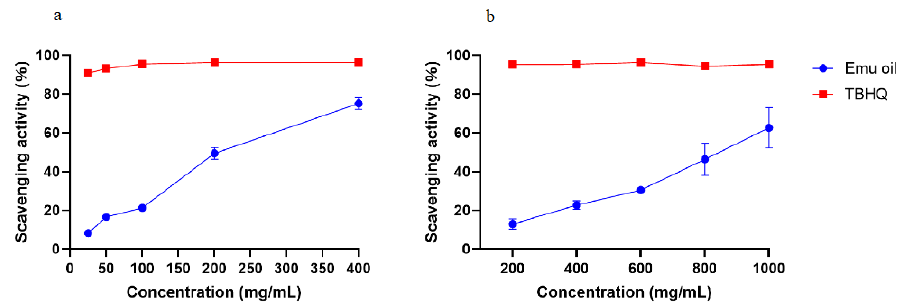
Figure 1. Radical scavenging activities of emu oil. ( a ) DPPH free radical scavenging activity assay, and ( b ) ABTS radical scavenging activity assay.